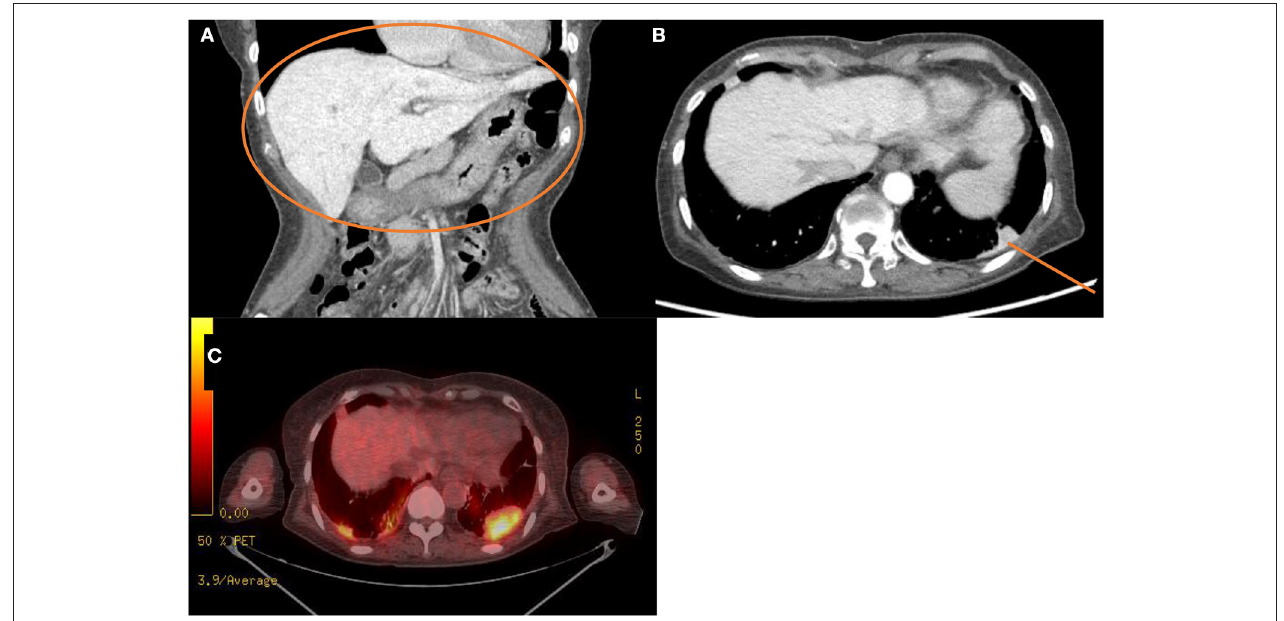
FIGURE 1 | Radiologic findings of the abdominal cavity and the chest. (A,B) Initial computed tomography scan of the abdominal cavity and the chest. This scan shows diffuse increased liver intensity [ (A) , orange circle] and scattered hyperattenuation nodular consolidations in the subpleural areas of both lungs [ (B) , orange line].